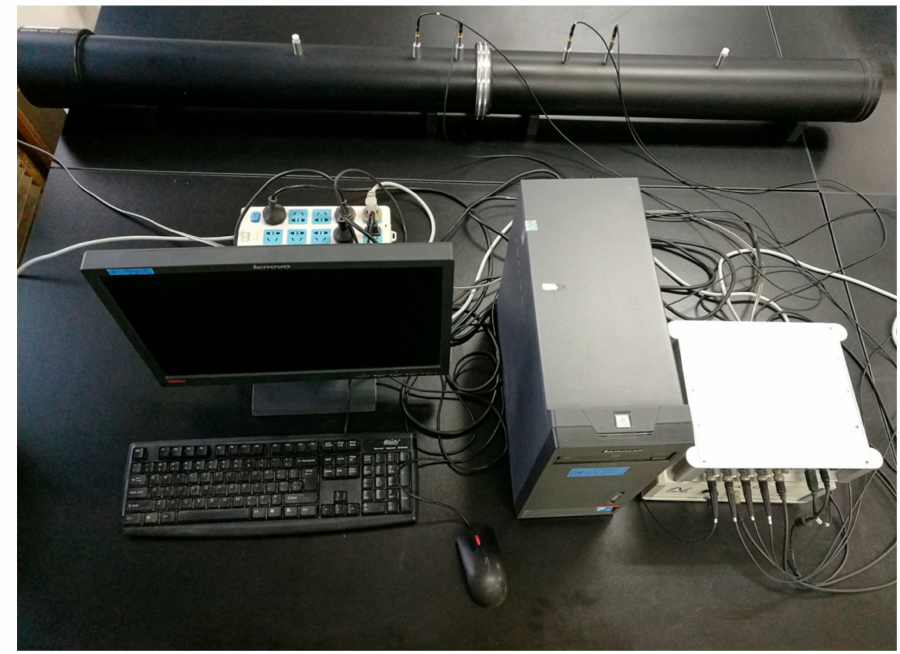
Figure 2. Photograph of the impedance tube testing